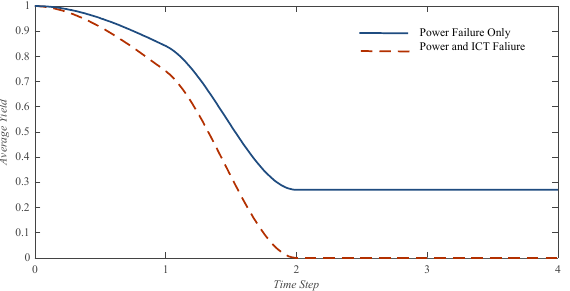
Figure 3. Average yield for Scenarios I and II. In Scenario 1, the yield following the first contingency drops from 1 to about 0.84, and then drops again to about 0.27 before the cascade stops. In Scenario II, since it involves failures within multiple CIs, the yield drops more sharply to zero.